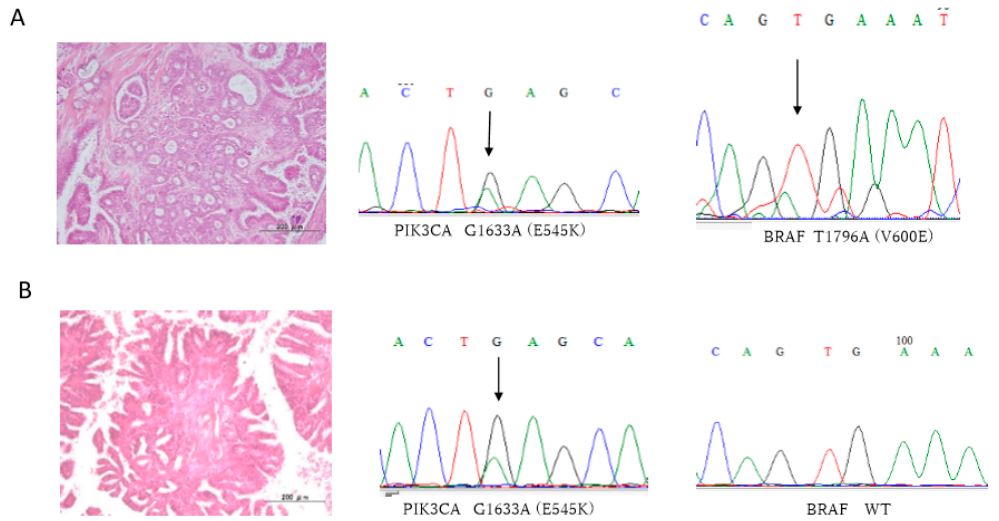
Figure 2. Representative positive staining of p53 ( A ) and ARID1A ( B ). Nuclear staining of p53 and ARID1A in an LGSC case.